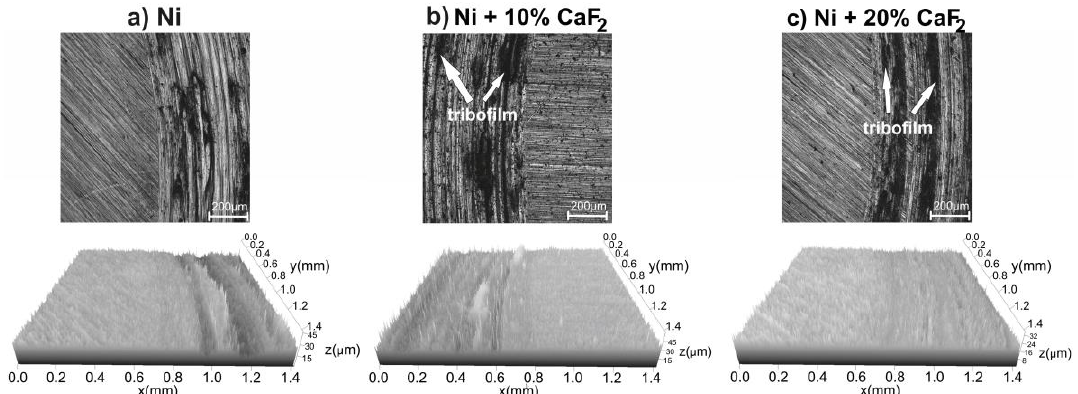
Figure 8. Stereometrics profiles of counter-specimens mated with produced sinters, after wear test at 400 °C.